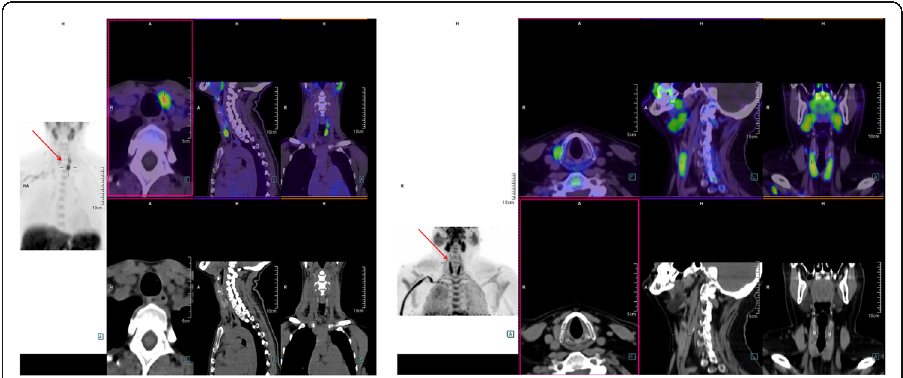
Fig. 1 Two very different 11 C-Choline PET/CT images. 11 C-Choline positron emission tomography/computed tomography (PET/CT). Arrows mark the suspected hyperfunctioning parathyroid gland. Left: Image deemed of ‘ high certainty ’ by all three readers. Right: Image deemed of ‘ low certainty ’ by the expert reader (no images were deemed of low quality by all three readers). In the image to the right, choline uptake in